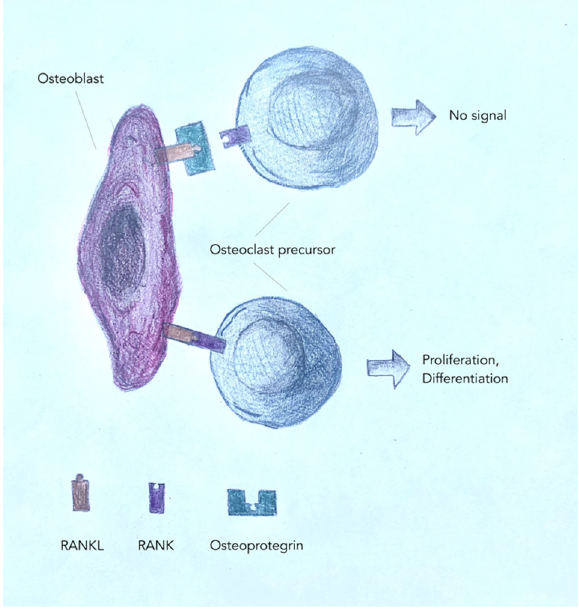
Figure 2. Mechanisms of osteoblast/osteoclast regulation.